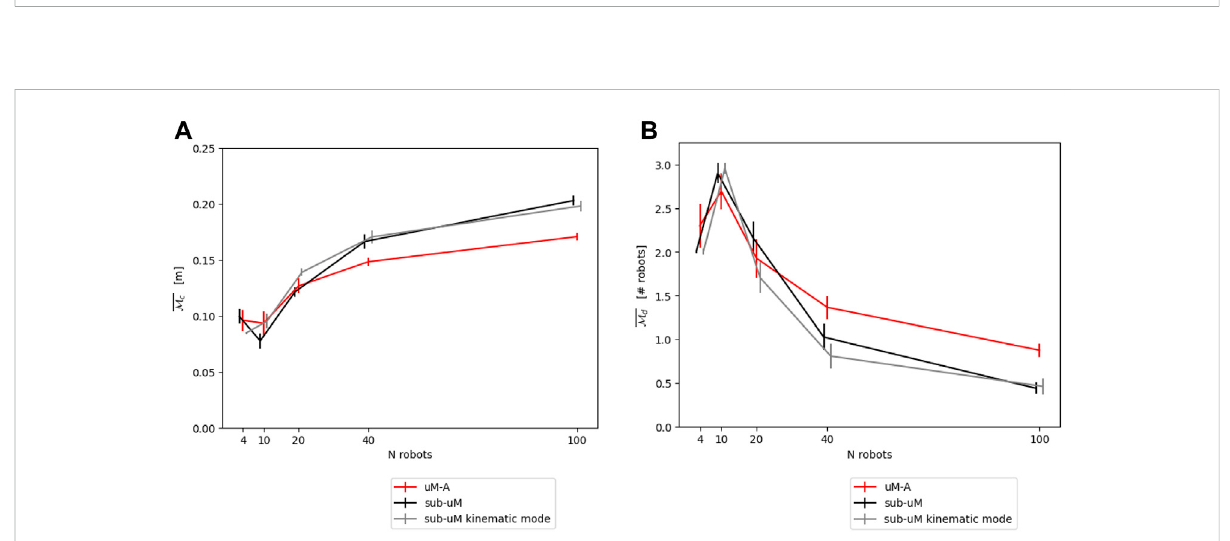
FIGURE 4 (A) Comparison between μ M-A (using kinematics) and the submicroscopic model using the continuous metric M c . (B) . Comparison between μ M-A (using kinematics) and the submicroscopic model using the discrete metric M d